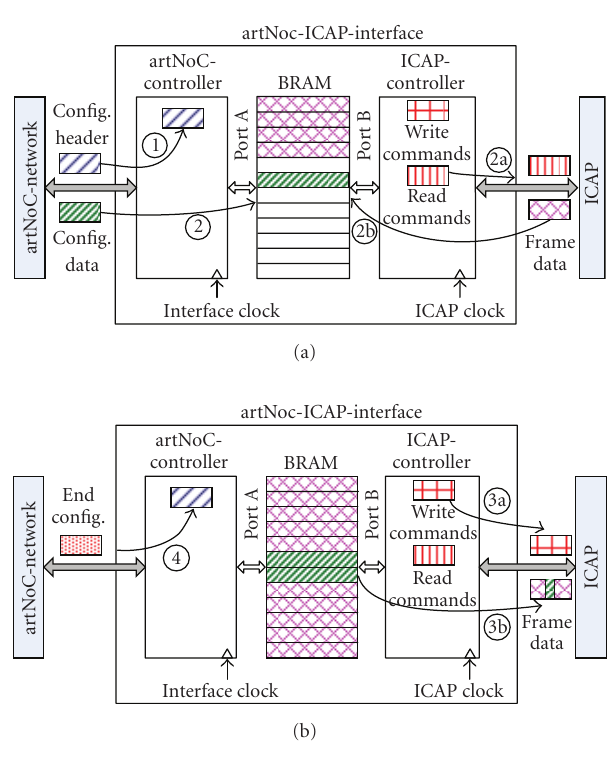
Figure 8: artNoC-ICAP-interface configuration